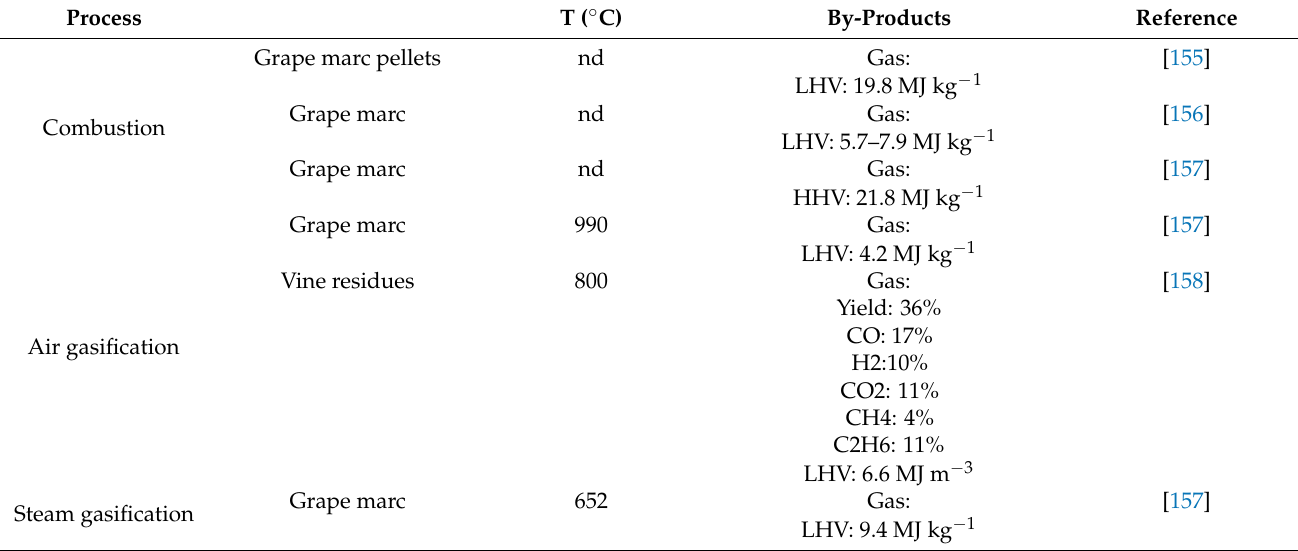
Table 16. Summary of the thermal conversion of winery